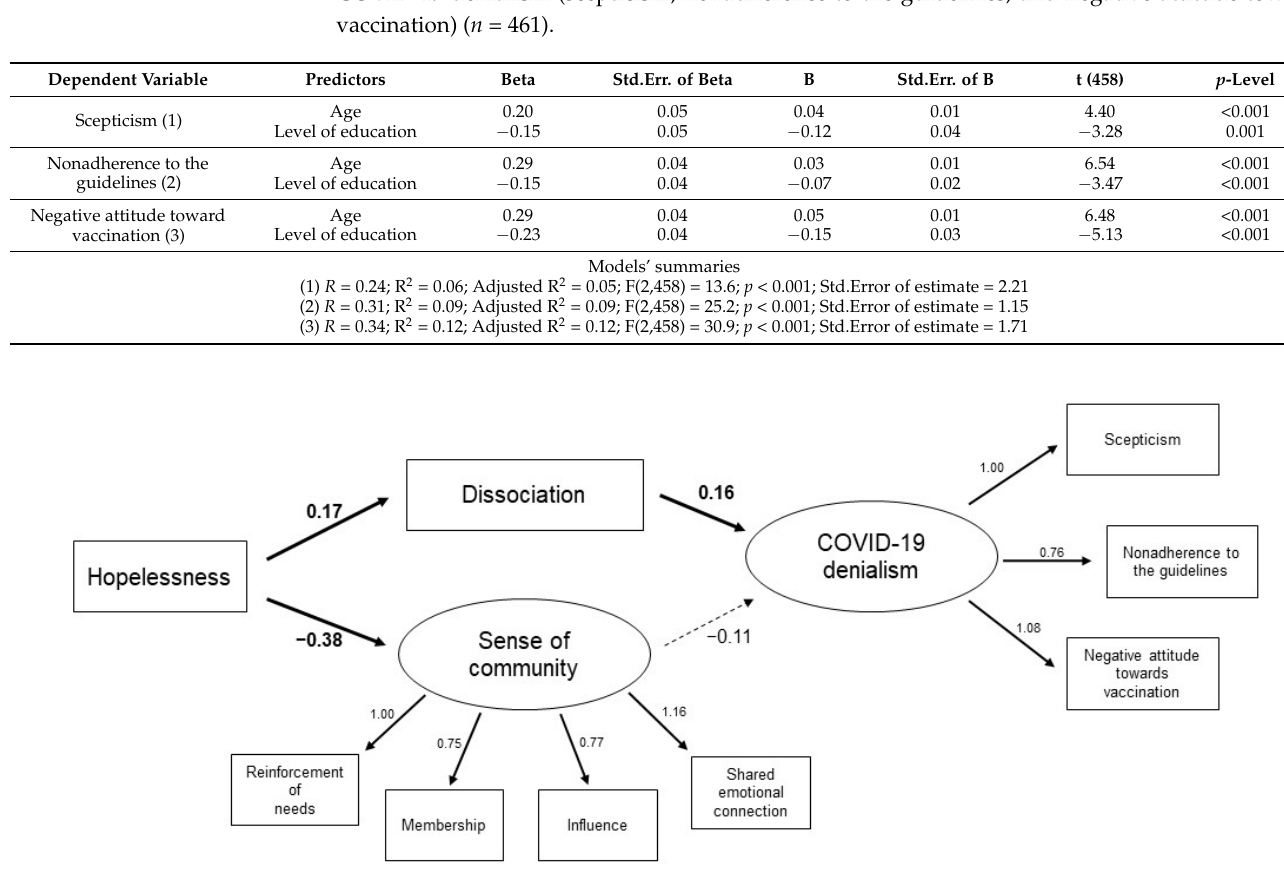
Figure 1. Estimate structural equation model with hopelessness as predictor of dissociation and sense of community, and dissociation as predictor of COVID-19 denialism ( n = 461). The solid lines represent statistically significant paths ( p < 0.05), and the dashed lines represent not significant paths.